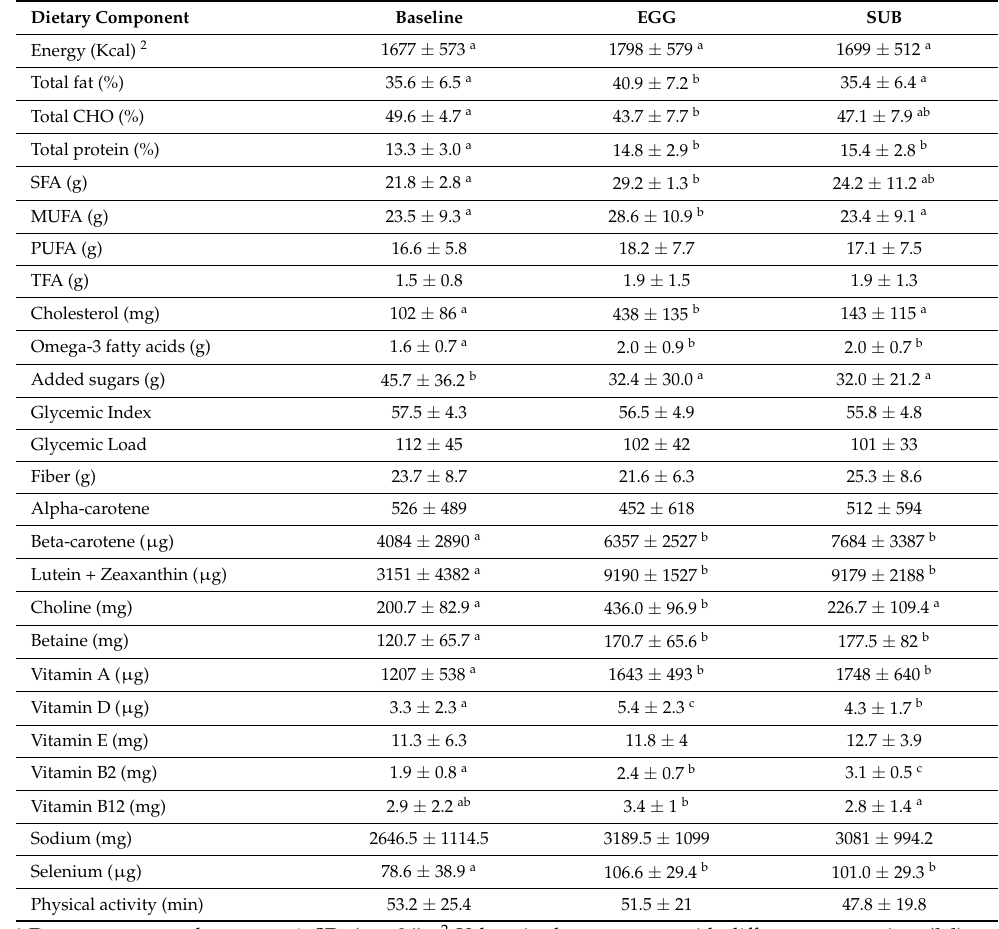
* Data are presented as mean ± SD, (n = 24). 2 Values in the same row with different superscripts ( a–c ) are significantly different at a p -value < 0.001. Abbreviations: CHO = carbohydrates; SFA = saturated fatty acids; MUFA = monounsaturated fatty acids; PUFA = polyunsaturated fatty acids; TFA = trans fatty